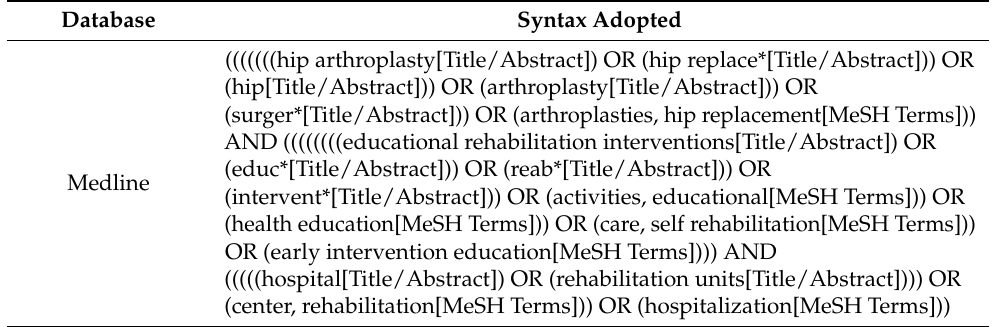
Table 1. Syntaxes of combined descriptors in the scientific database search. Lisbon,